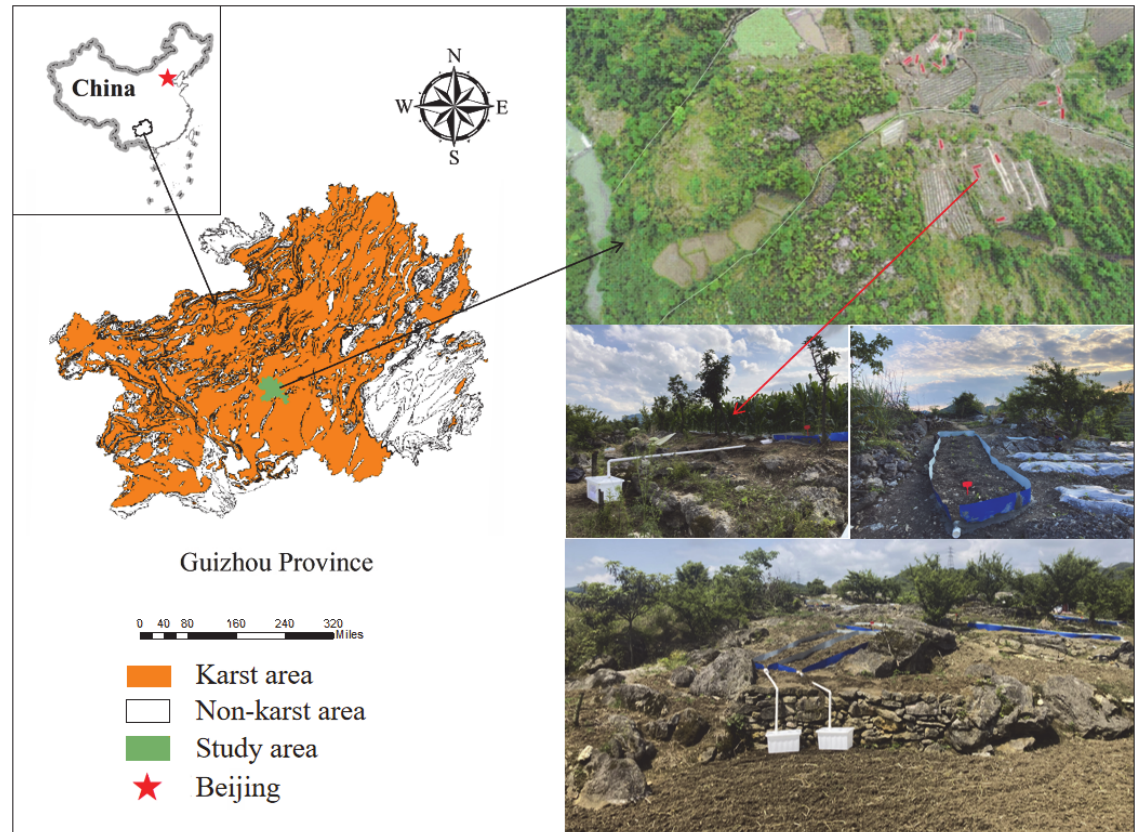
Figure 1. Geographical location and partial overview of the runoff community.